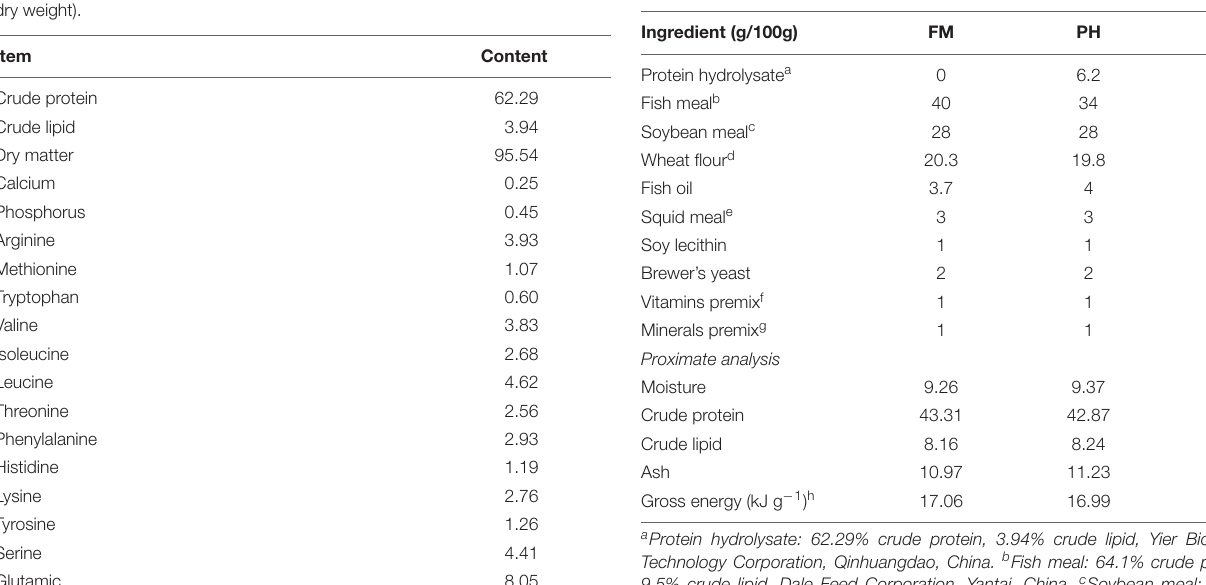
TABLE 3 | Composition and proximate analysis of the experimental diets.